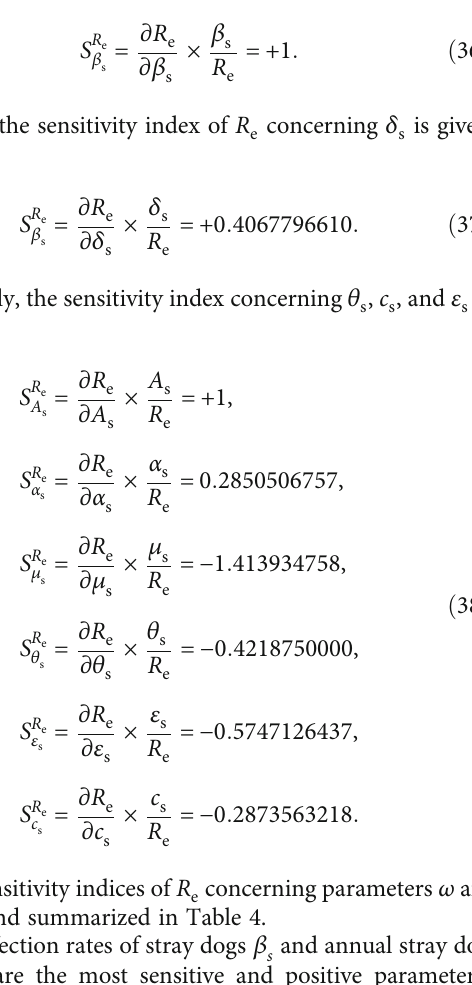
s ) and culling (parameter